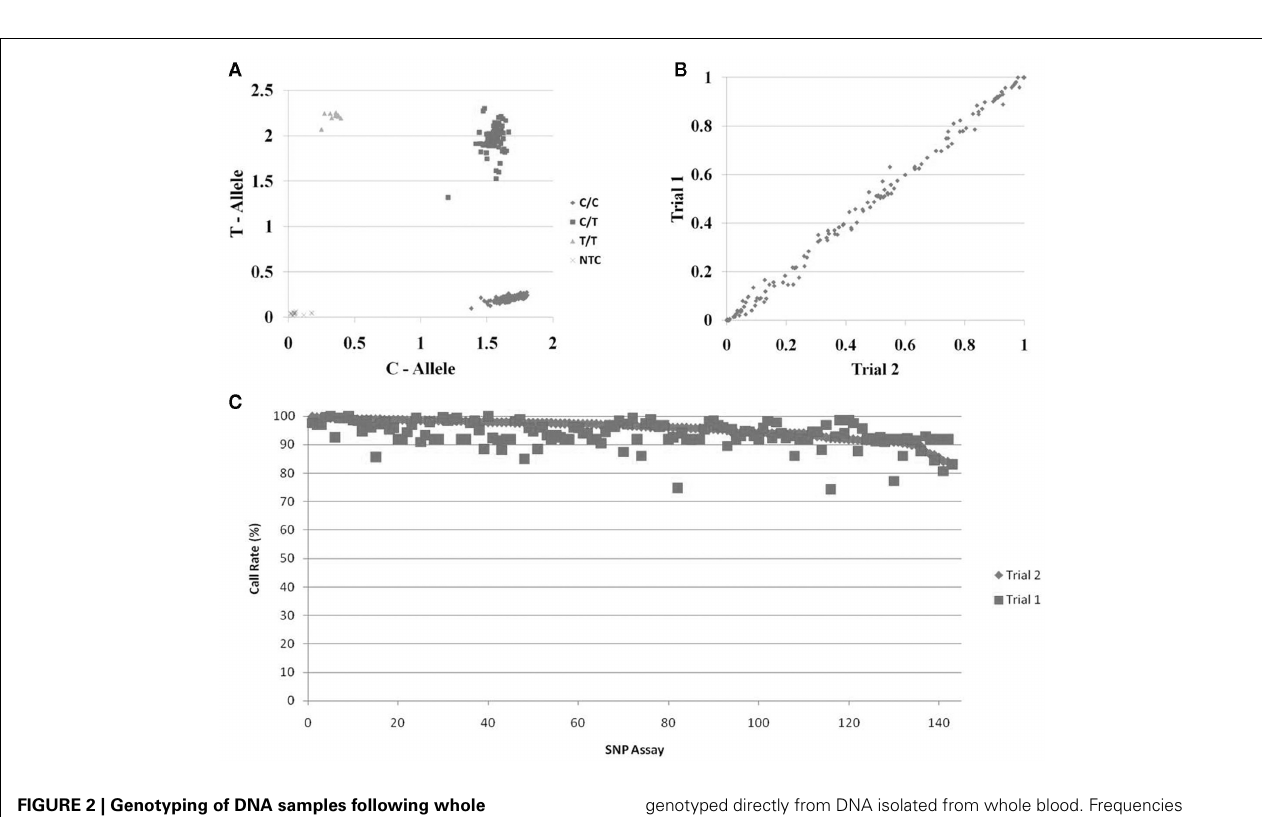
FIGURE 1 |Analysis of whole genome amplified DNA samples. (A) Quantification of DNA concentration by real-time PCR analysis of RNase P gene. DNA from whole genome amplified and unamplified samples were analyzed by RNase PTaqman™ assay. DNA from unamplified samples was diluted equivalently to that amount of dilution by the whole genome